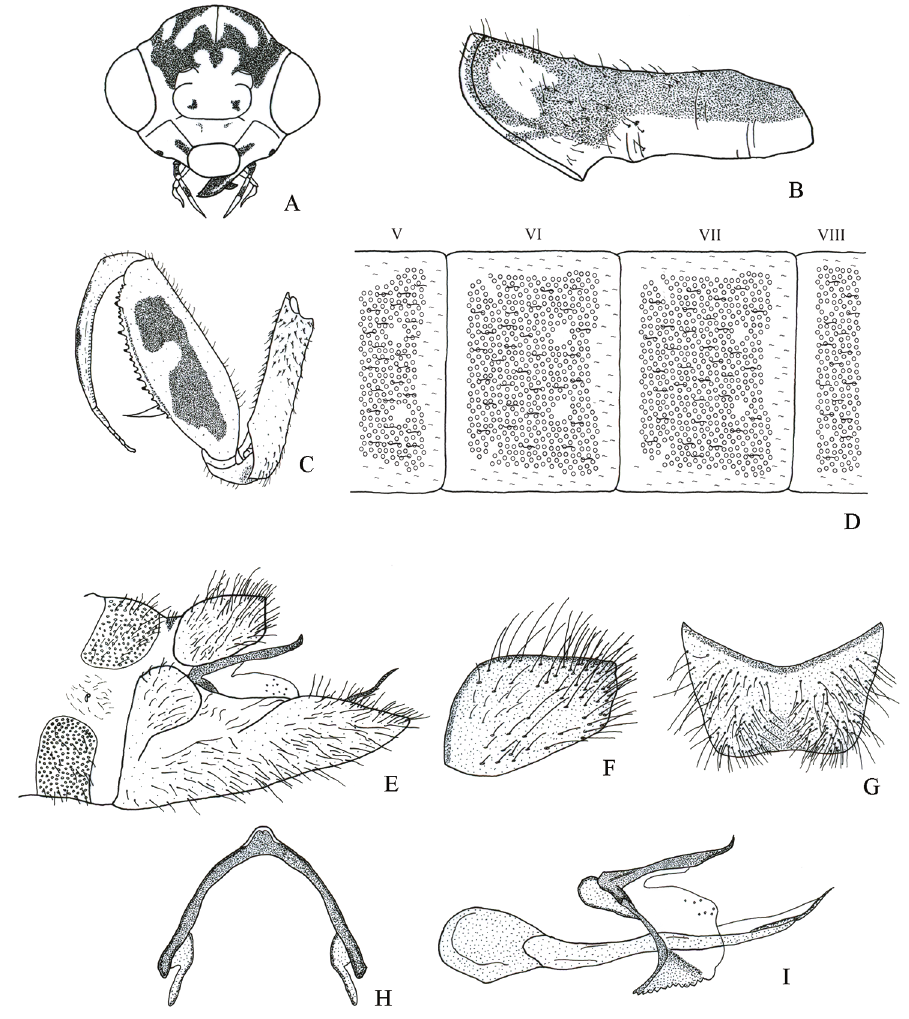
Figure 9. Structures of the male of Nolima pinal . A head, frontal B prothorax, lateral C left foreleg, lat- eral D abdominal terga V–VIII, dorsal E external terminalia, lateral F left ectoproct, lateral G ectoprocts, dorsal H gonarcus, dorsal I internal terminalia,